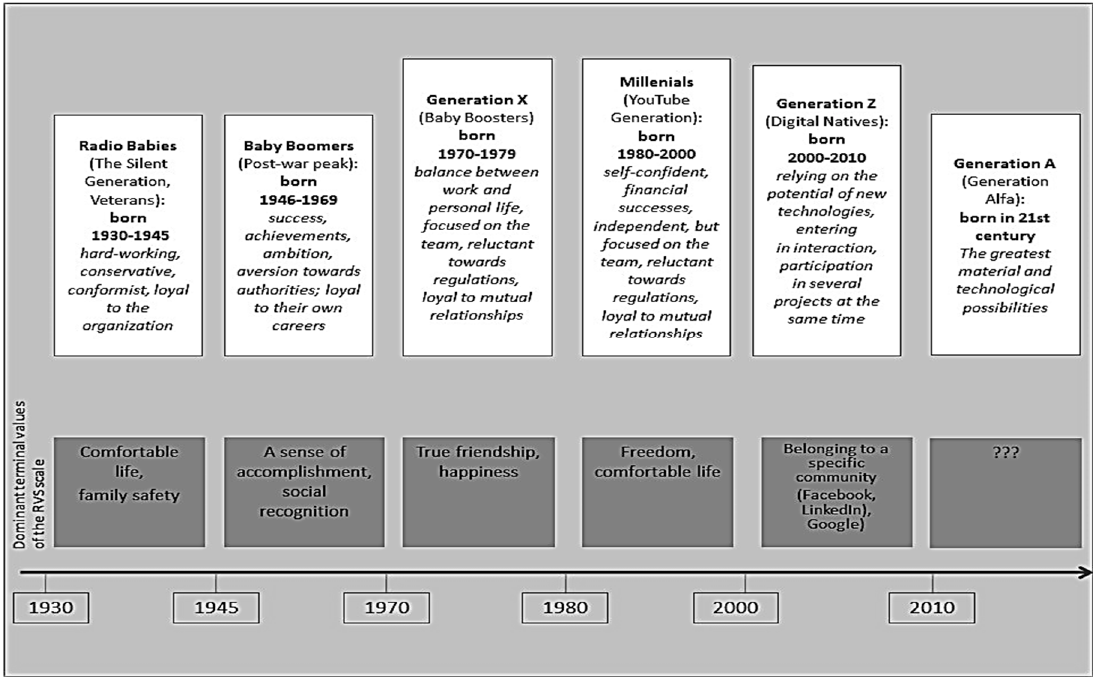
Figure 1. The evolution of generations of people and their values through decades. Source: (Robbins 2008; Wereda 2008; Cielemecki and Wereda 2018).